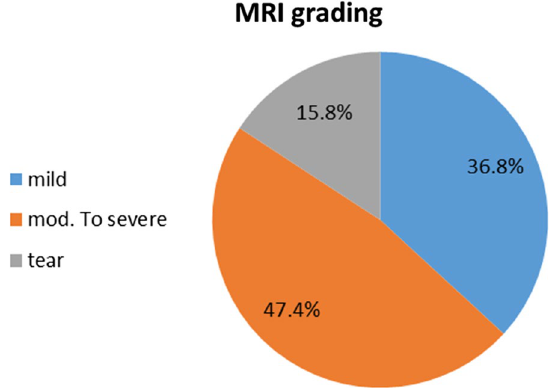
Fig. 1 MRI grading of supraspinatus tendon abnormalities among